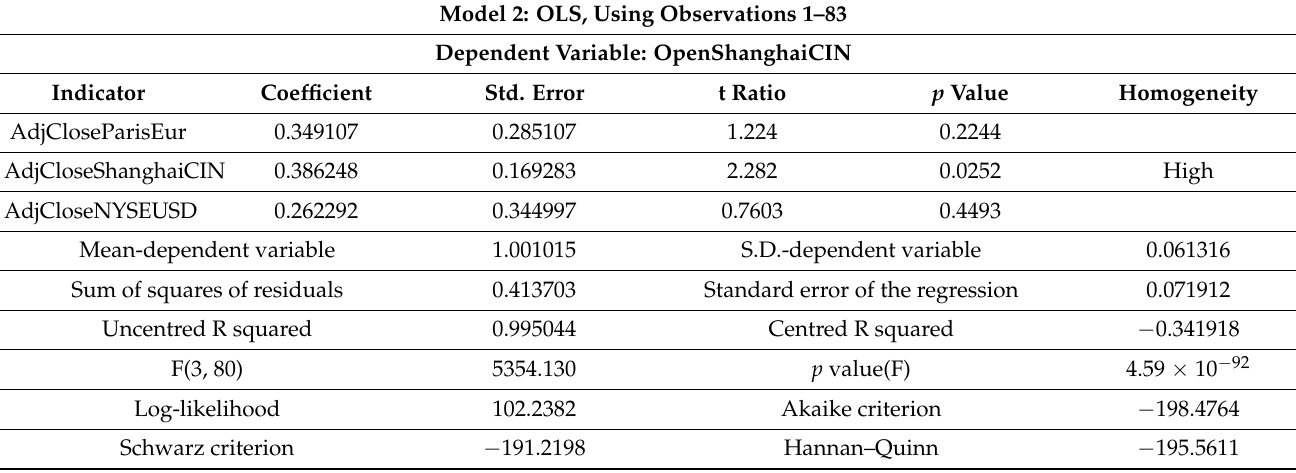
Table 4. Summary of the Asian volatility matrix model. Model 2: OLS, Using Observations 1–83